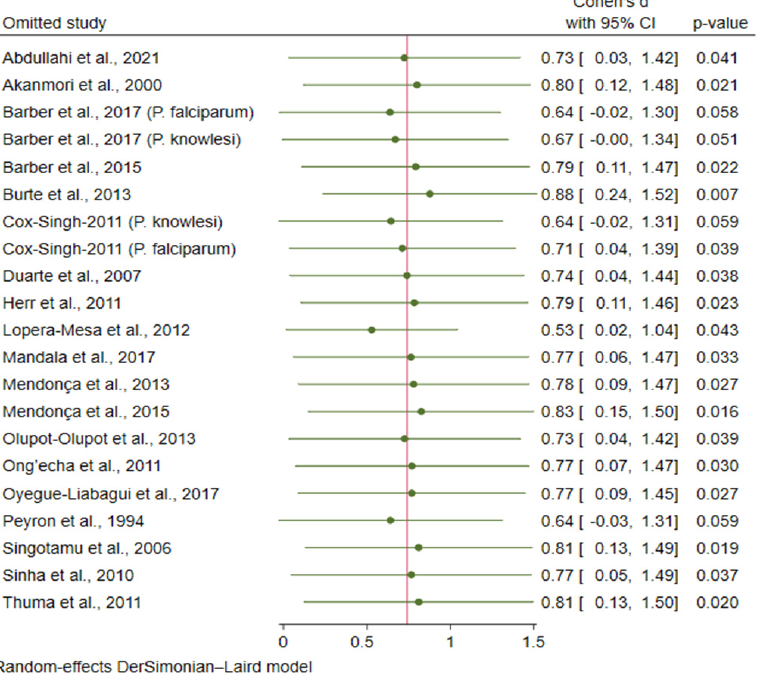
Figure 8. Leave-one-out analysis demonstrating the outliers in the meta-analysis. Abbreviations: CI, Figure 8. Leave ‐ one ‐ out analysis demonstrating the outliers in the meta ‐ analysis. Abbreviations: CI, confidence interval . confidence interval. Symbols: green dot, pooled effect estimate in each re-run analysis.